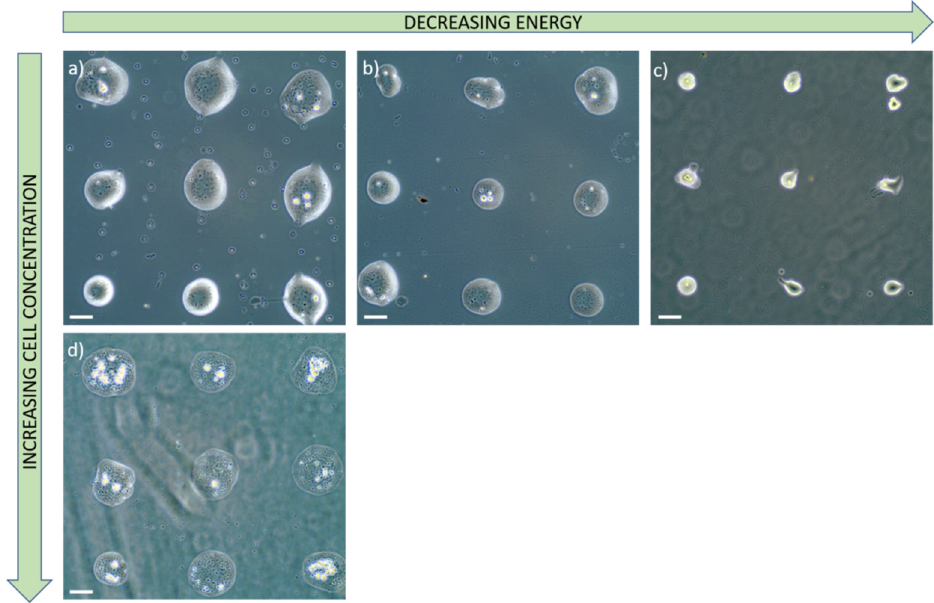
Figure 11. Printing results of muscular progenitors by LIFT. The laser pulse energy was 23 μ J ( a ) and ( d ), ( b ) 17 μ J and ( c ) 14 μ J. Two different cell concentrations were used: 5 million per milliliter ( a , b , c ) and 15 million per milliliter ( d ). Scale bar is 100 μ m.